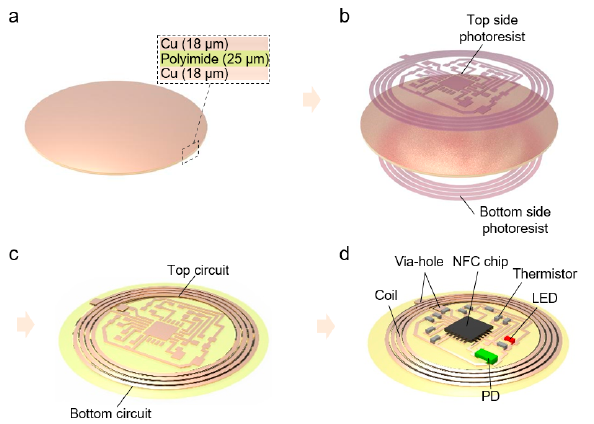
Figure 4. Fabrication process. ( a ) Preparation for Cu/PI/Cu foil. ( b ) Double-sided photolithography for pattering. ( c ) After Cu wet etching with etchant. ( d ) Soldering electric component soldering and forming via-hole with silver paste.